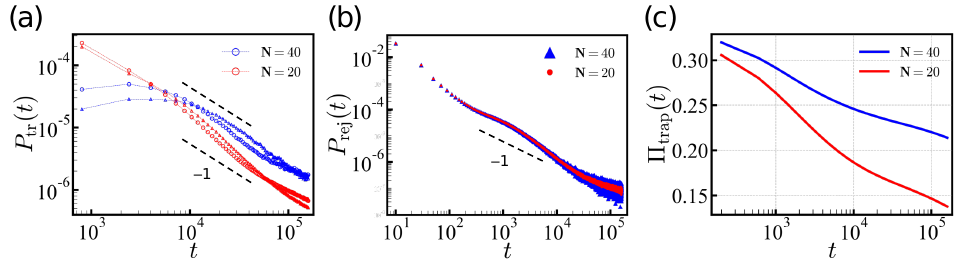
Figure 2. ( a ) The translocation time distributions for 2 20 sequences of N = 20. The number of translocated sequences are measured in the time interval [ t − δ t /2, t + δ t /2] with δ t = 1.6 × 10 3 MCT. The symbols ◦ and (cid:52) represent the cis -to- trans and reverse directions, respectively. ( b ) Distributions of rejection times, measured within the time interval [ t − δ t /2, t + δ t /2] with δ t = 20 MCT. Dashed lines are guides for the power-law relation, P ( t ) ∼ t − 1 . ( c ) Logarithmic decay of trapped populations, Π trap ( t ) , normalized by the total number of translocation